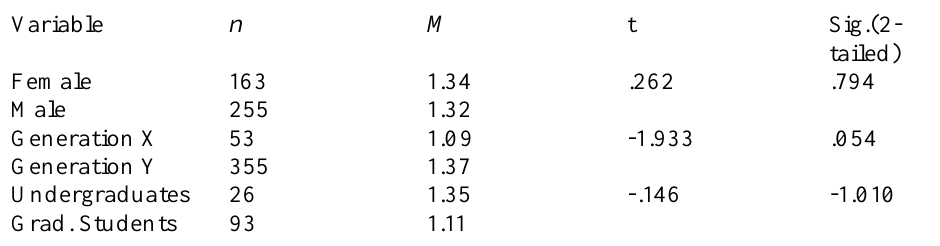
Student Satisfaction with Partially Online Courses